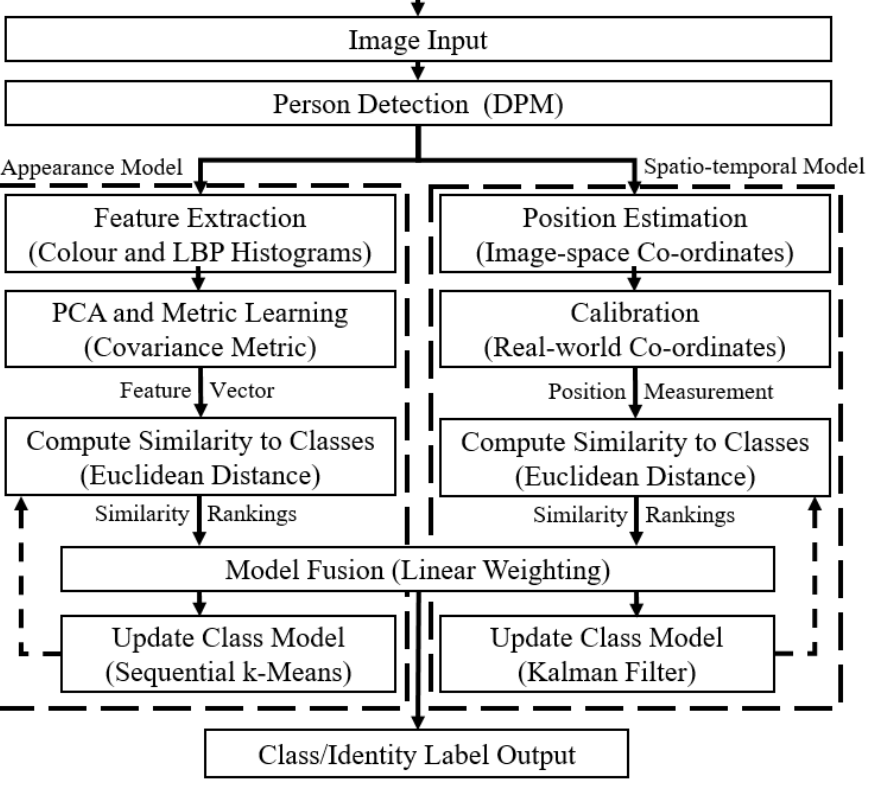
Figure 6. A flowchart of the combined appearance and spatio-temporal models in parallel, leading to the model fusion step, with the class updates feeding back into the classification step for the next